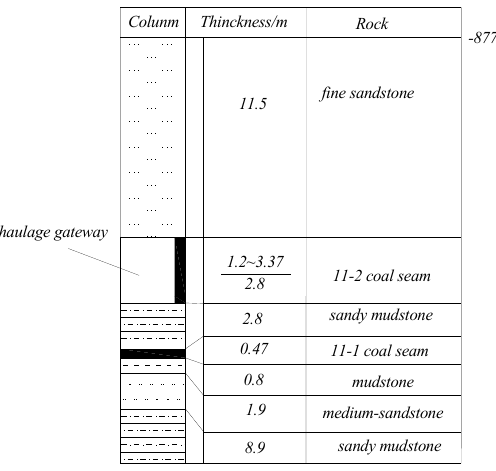
Figure 13. Geological borehole profile of the 1111(1) longwall working face.